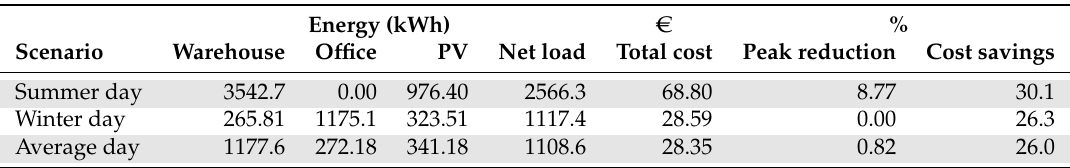
Table 7. Results for the case illustrating the effect of PV without demand response for three temperature scenarios in the